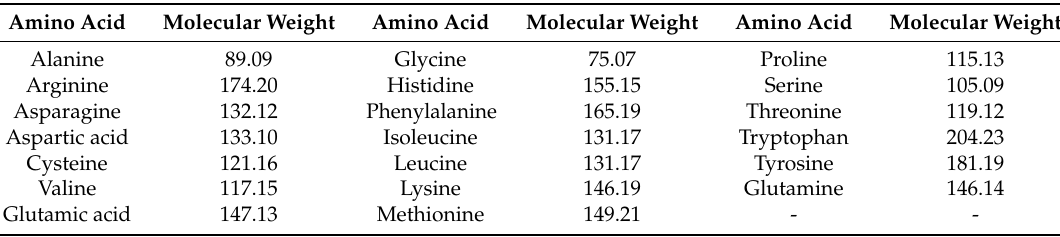
Table 1. Molecular weights of amino